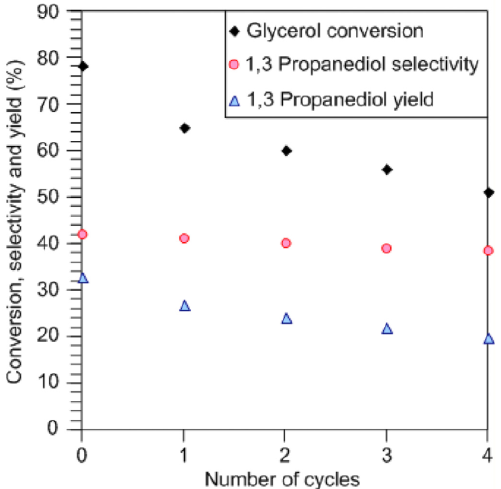
39 Figure 20. The glycerol conversion and selectivity to 1,3-PG employing Pt/WO x /SBA-15 catalysts. Reaction conditions: 210 °C, 0.1 MPa H 2 , 1.02 h − 1 WHSV. Reproduced from [140] with permission from the American Chemical Society (ACS). 5.4. Pt/WO x /Al 2 O 3 Catalysts Lei et al. studied the stability of Pt/WO x /Al 2 O 3 catalysts in a liquid phase continuous flow reactor at 180 °C and 5 MPa H 2 using 50 wt.% glycerol solutions. Their results initially showed a glycerol conversion of 57% with a selectivity to 1,3-PG of 40%. After 100 h of reaction, the conversion decreased to ~45% and began to decrease steadily to 25% conver- sion at 600 h of reaction, after which time it remained constant. The selectivity to 1,3-PG, on the other hand, remained unchanged for 700 h of reaction. The characterization results revealed a preservation in the structure of the WO x /Al 2 O 3 support but an agglomeration